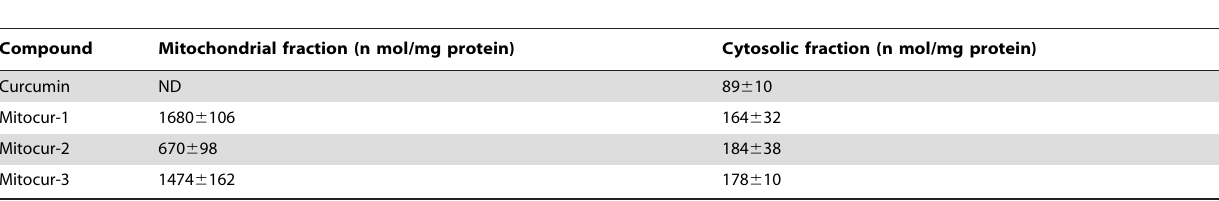
Table 1. Cellular uptake of curcumin and mitocurcuminoids-1, 2, and 3.